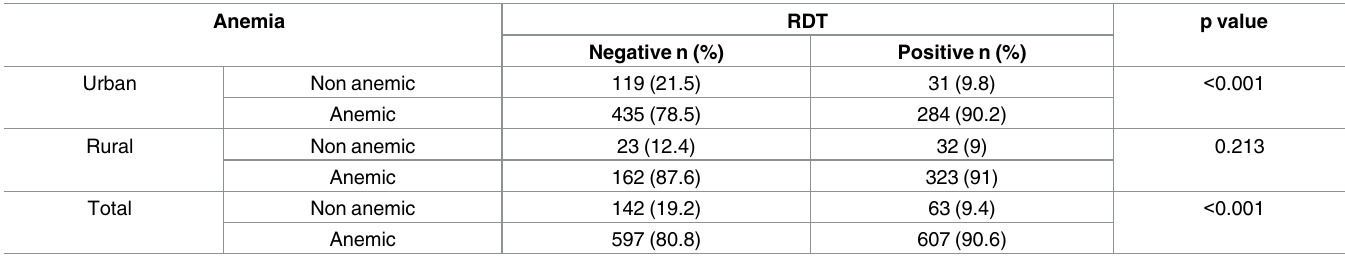
Table 3. Malaria and anemia by setting in children, Bata district, June-August